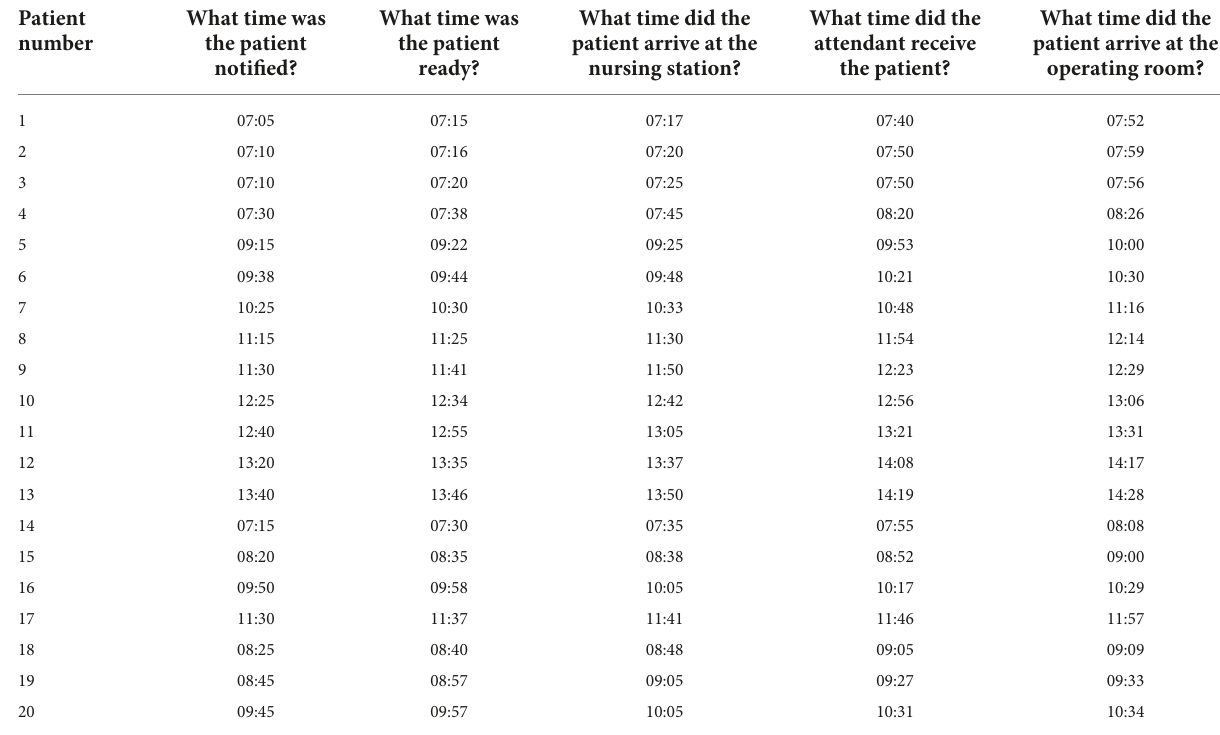
TABLE 1 The actual time spent in the workplace measured in hours and